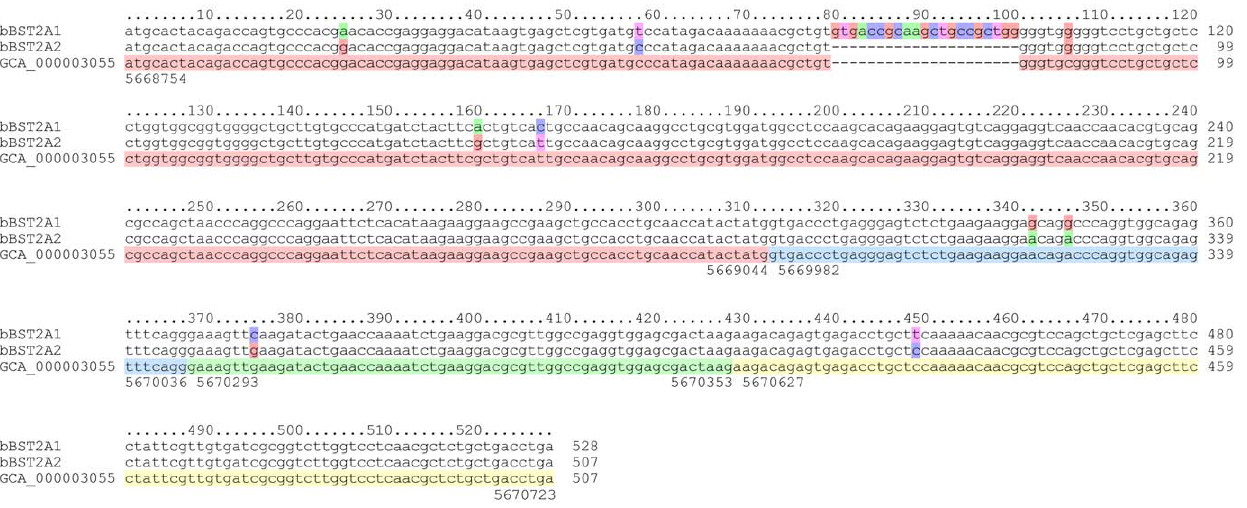
Figure 2. Multiple alignment of bBST-2A1, bBST-2A2 and the corresponding regions in the bovine genome. The coloured boxes of bBST-2A1 and bBST-2A2 indicate nucleotide differences. The coloured boxes in the genomic sequences (GenBank, GCA_000003055.3) show the exon structures. The numbers at the top or bottom of the alignment indicate the relative positions or the absolute genomic positions on chromosome 7, respectively.